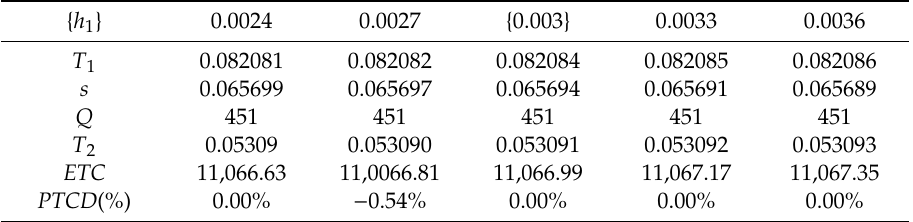
Table 5. Sensitivity analysis when the hazard rate of sold product before inspection